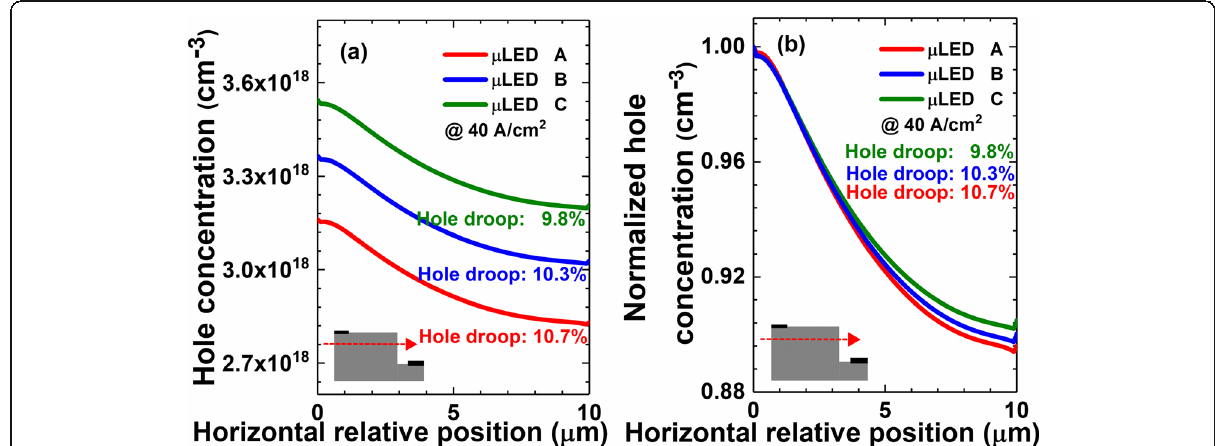
Fig. 3 ( a ) Numerically calculated hole concentration profiles, and ( b ) normalized hole concentration profiles in the first quantum well near the p- EBL for μ LEDs A, B and C, respectively. Inset figure shows the position along which the hole concentration profiles are captured. Data